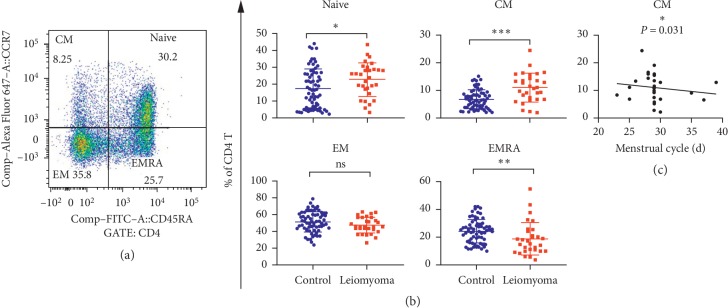
Distribution characteristics and significances of the subgroups of CD4+ cells in 30 leiomyoma patients and 68 healthy controls. (a) Flow analysis of CD4+ naïve, central memory (CM), effector memory (EM), and terminal differentiated effector memory (EMRA) cells, respectively. (b) Comparison of above cells between patients and controls. (c) Association of CD4+CM cells with menstrual cycle. ∗P < 0.05. ∗∗P < 0.01. ∗∗∗P < 0.001. ns, not significant.